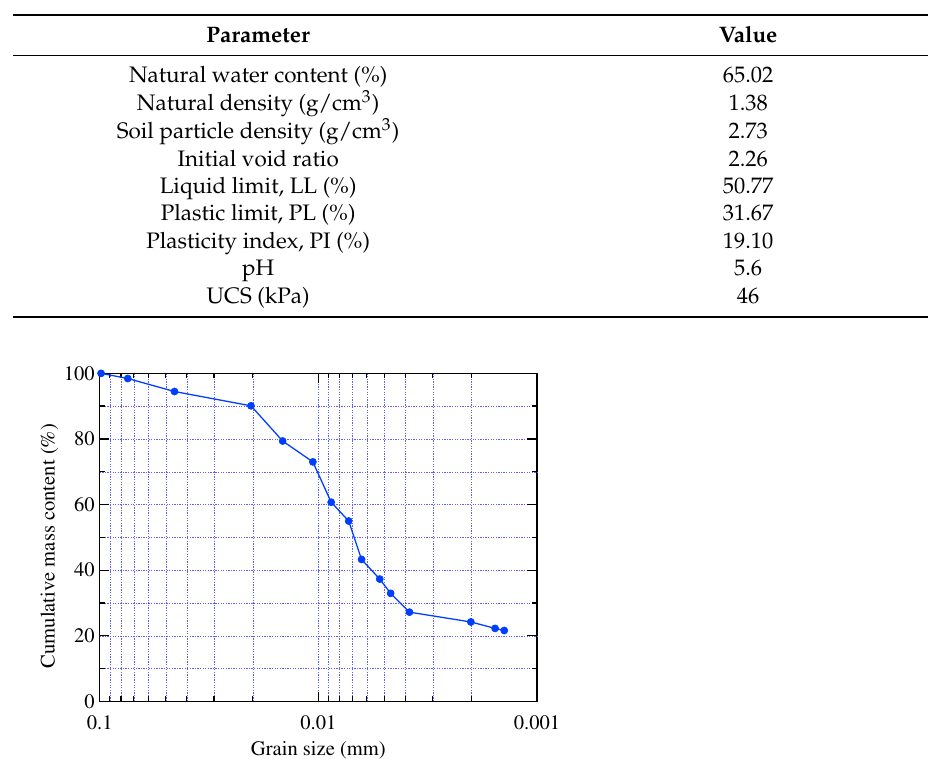
Table 2. Basic physical and mechanical parameters of natural Ningde marine muck (UCS: unconfined compressive strength).